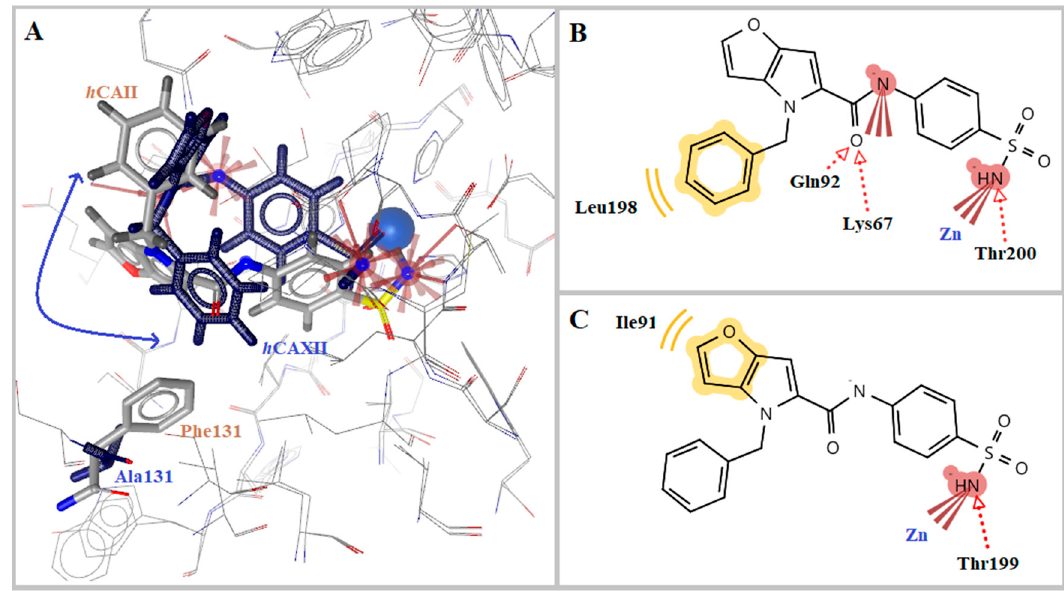
Figure 2. ( A ) Superposition of compound 7c bound to hCA II (grey) in comparison to hCA XII (blue), with specific residues labeled. ( B ) 2D interaction diagram of compound 7c docking pose interactions with the key amino acids in hCA XII and ( C ) in hCA II, Active site zinc is shown as a blue sphere, red dotted arrows indicate H-bond and yellow spheres hydrophobic interactions. Blue double-headed arrow indicates the direction of conformational change of the compound bound to hCA II in comparison to the hCA XII enzyme.